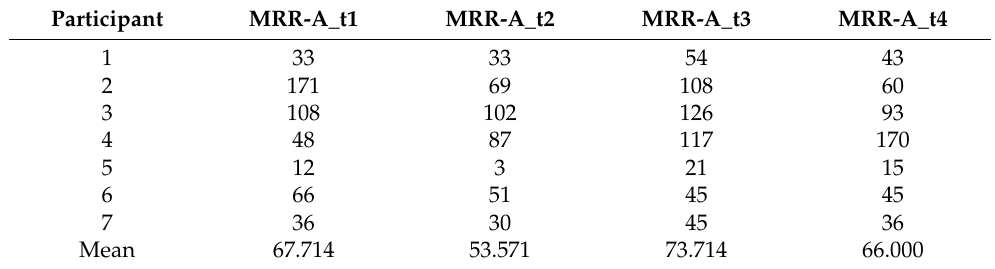
Table 12. MRR-A (syllables, total) individual and mean measurements at four assessment time points.